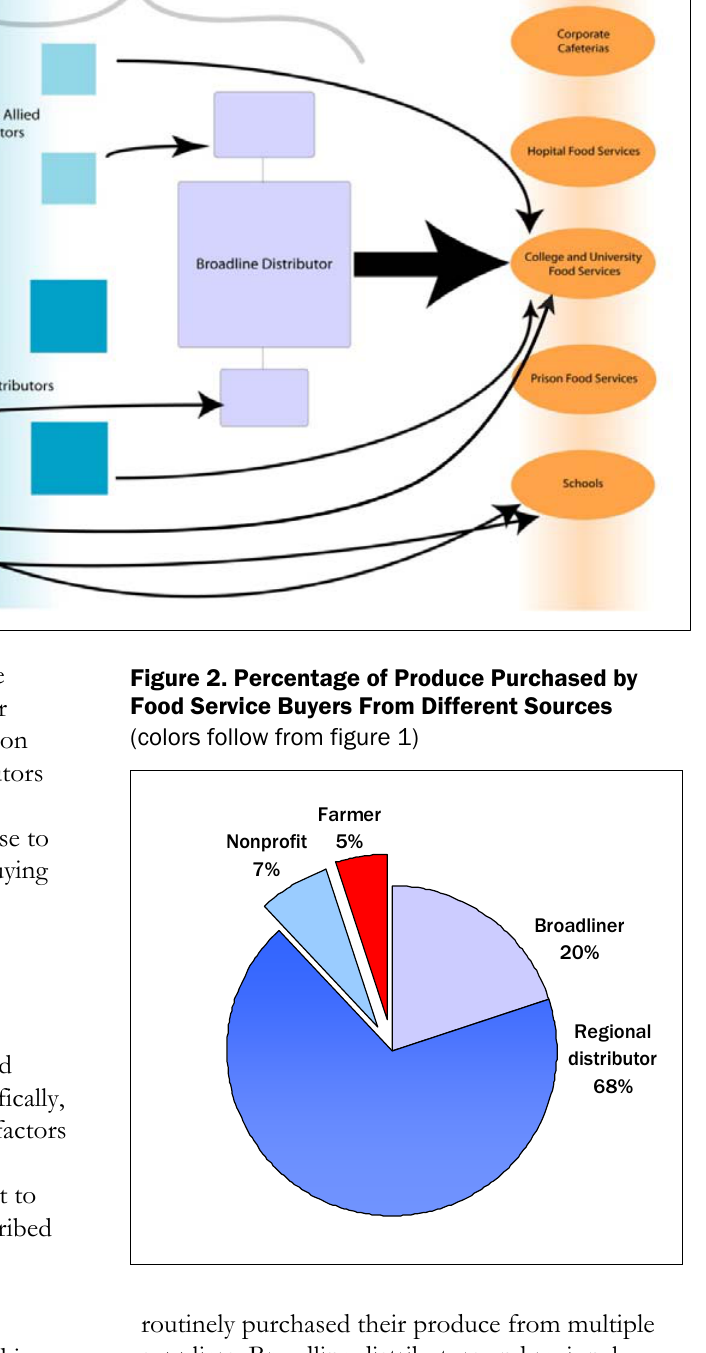
Figure 1. Supply Chain for Farm-to-Institution Programs